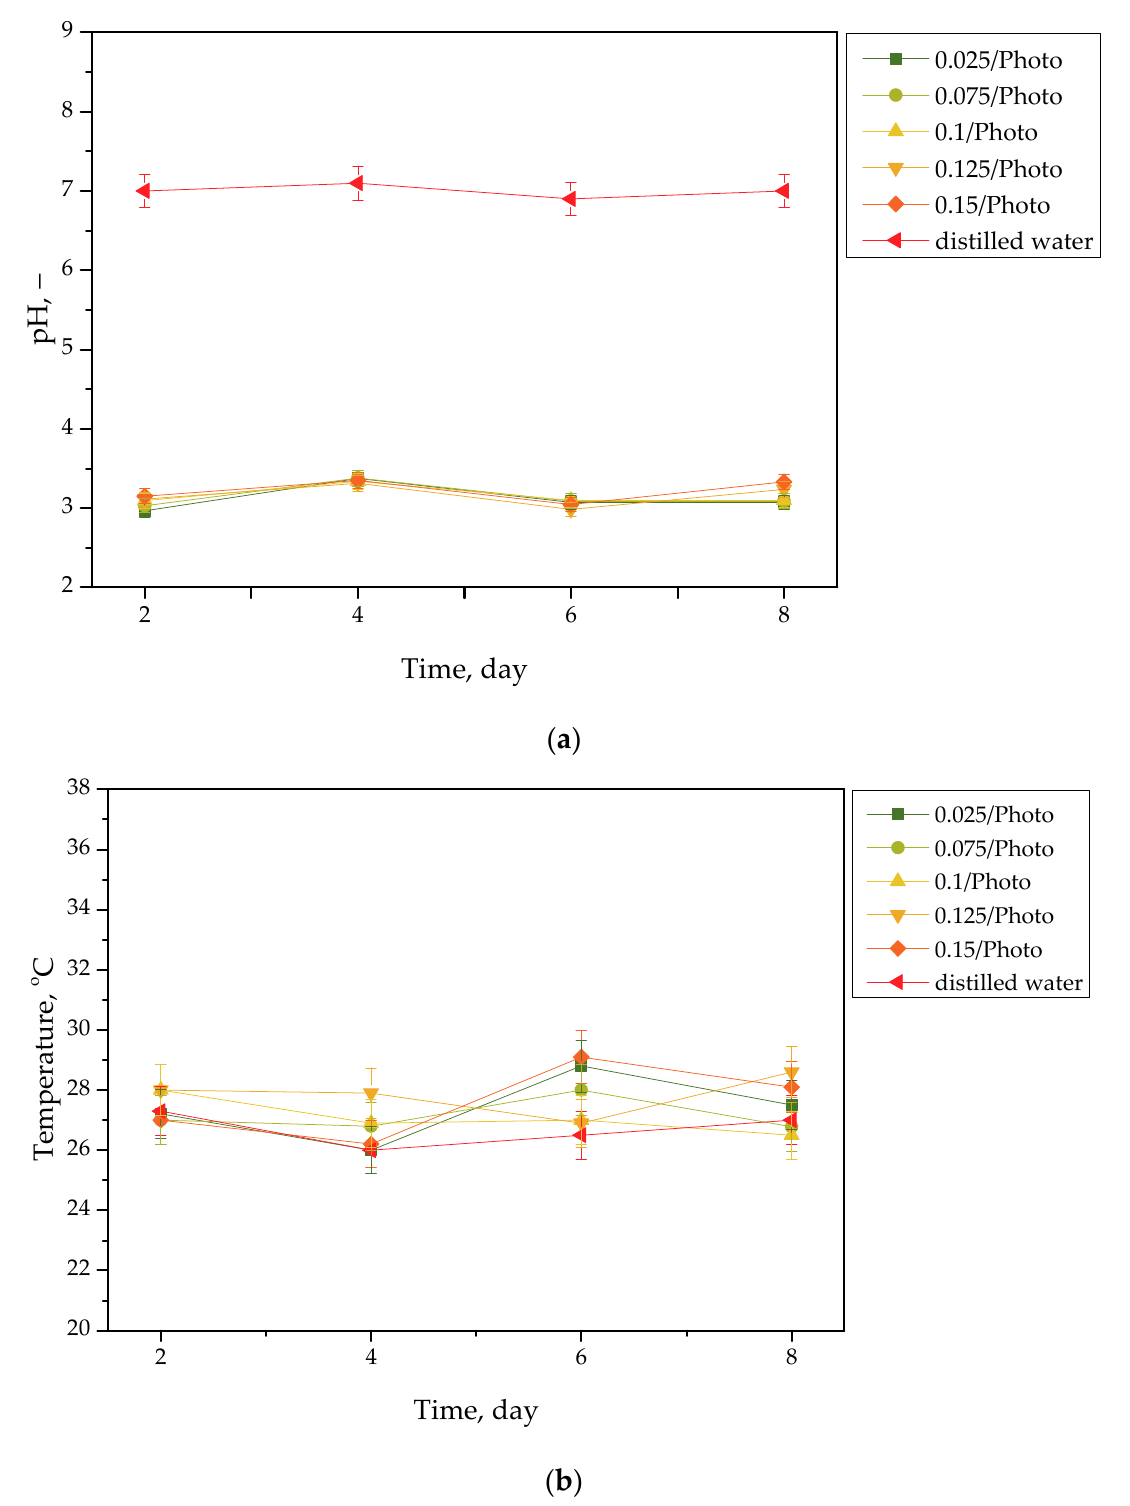
Figure 1. pH ( a ) and temperature ( b ) values of distilled water, measured during the hydrogels’ incubation period (n = 3, n—number of repetitions).